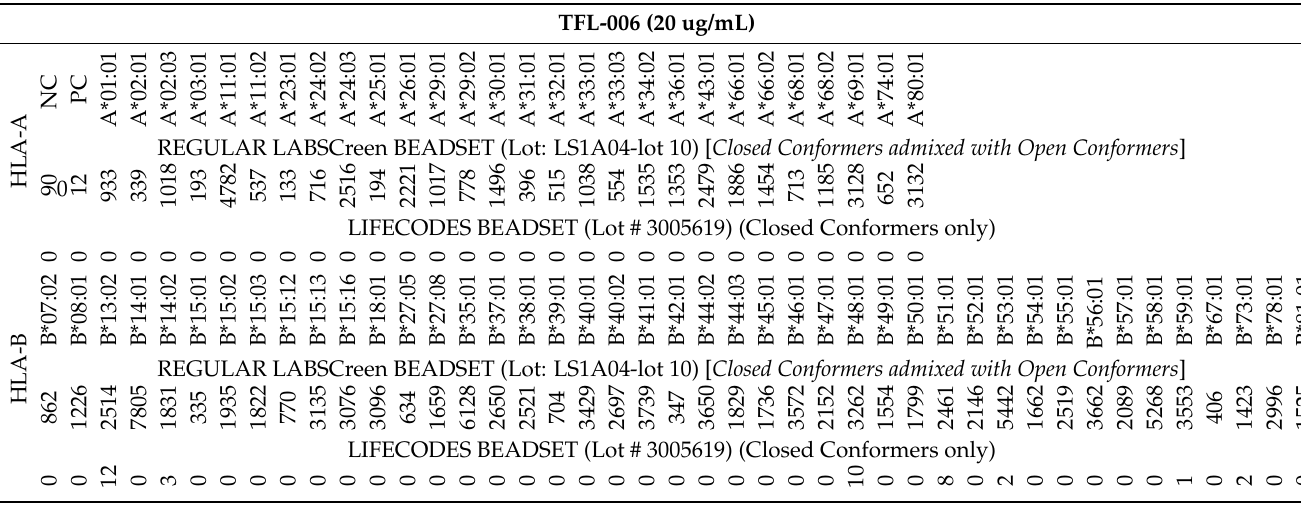
Table 5. Evidence showed that HLA-I polyreactive mAb TFL-006 bound to OCs ( β 2m-free α HLA HC) but not to CCs ( β 2m-associated HLA heavy chains or intact HLA molecules). TFL-006 bound only with LABScreen SABs (contained both open and CCs) but not with LIFECODES, which had only CCs, as established in previous reports